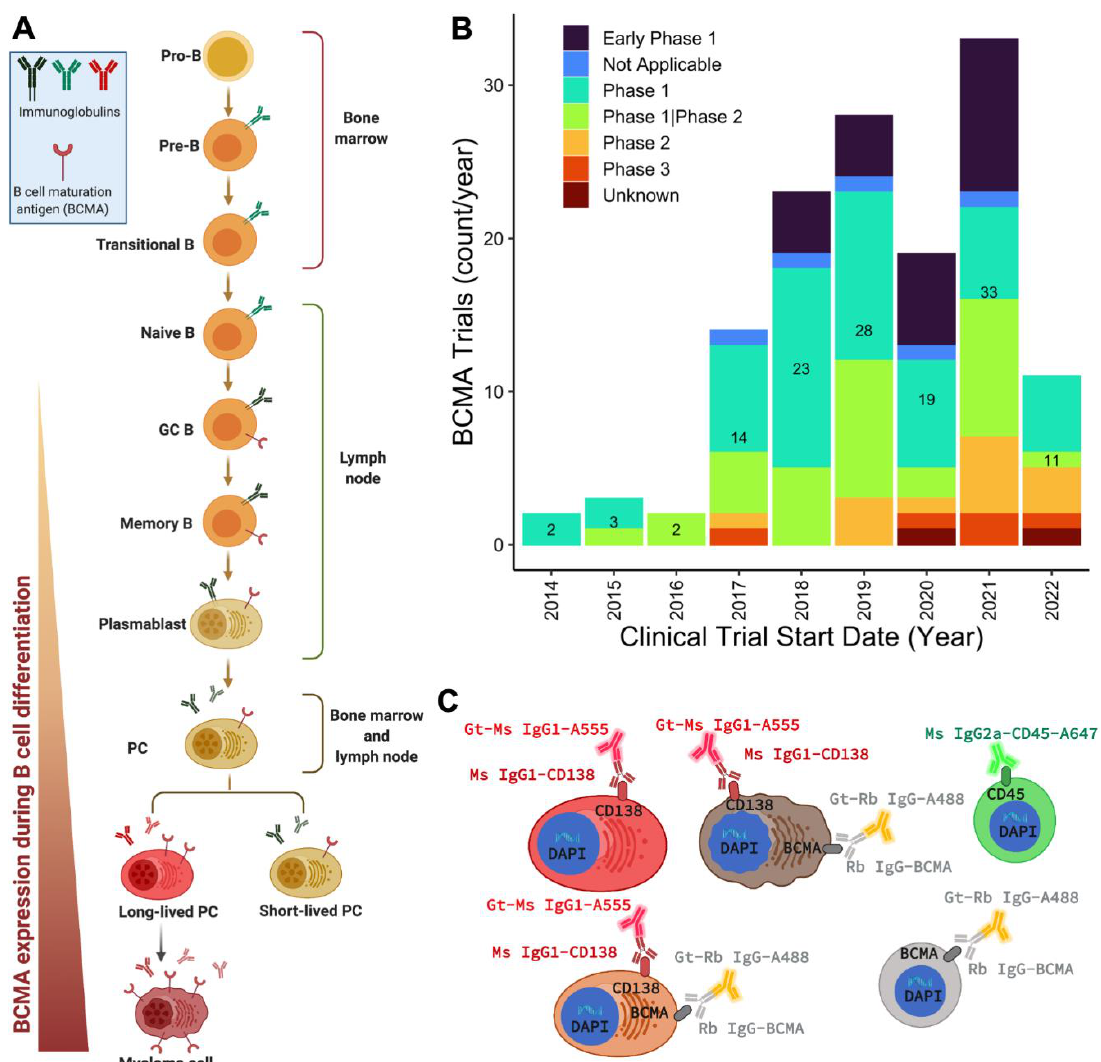
Figure 1. Assay rationale and Immunofluorescence targeting: ( A ) B-cell differentiation and BCMA expression during the B-cell maturation spectrum from GC B to mature plasma cells [7,8]. ( B ) Clinical studies involving BCMA as a therapeutic target of interest. Data from ClinicalTrials.gov (accessed on 1 May 2022) with “BCMA” as the search key term, as of April 2022. “Not Applicable” = study phase explicitly marked as “not applicable”. “Unknown” = no data entered for study phase.